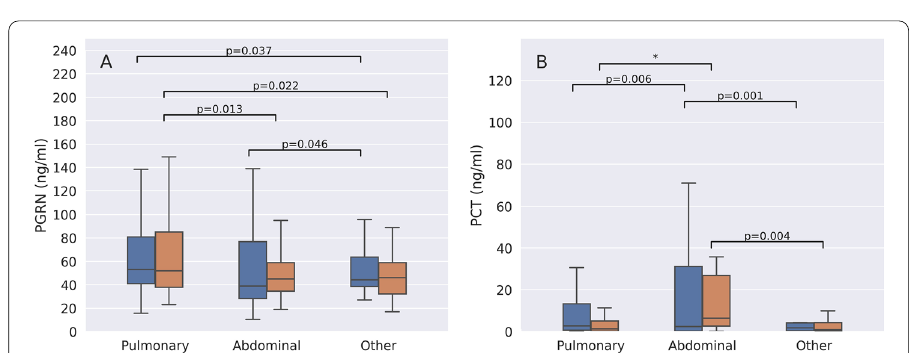
Fig. 3 Comparison of progranulin (PGRN) ( A ) and procalcitonin (PCT) ( B ) plasma concentrations in sepsis of pulmonary, abdominal or other origin. Data are presented separately for the exploratory (blue boxplots) and the confirmatory study (orange boxplots). Significant differences between groups are marked with bars and p ‑values. * Indicates a p value <